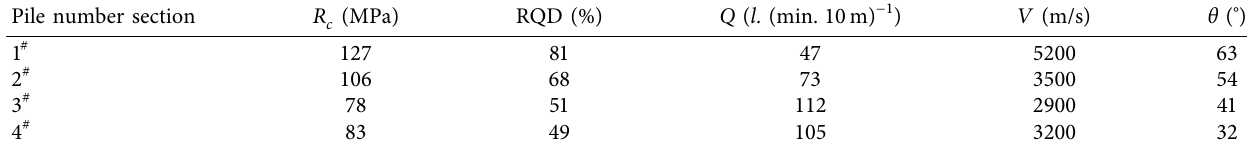
Table 3: The actual value of the index in the classic surrounding rock section.